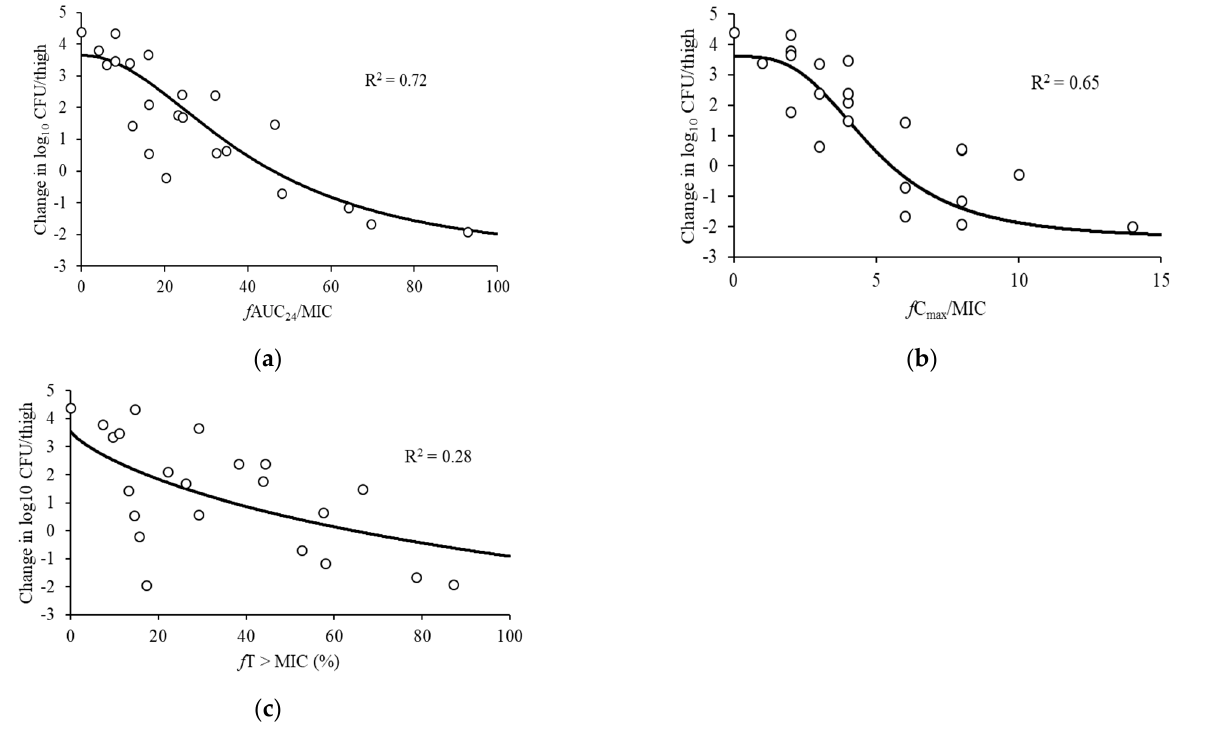
Figure 2. Relationships between the change in log 10 CFU/thigh at 24 h and PK/PD indices. ( a ) f AUC 24 /MIC, ( b ) f C max /MIC, and ( c ) f T > MIC for P . aeruginosa ATCC 27853. The horizontal dashed lines: organism burden at the start of therapy. Plot: mean for one thigh per mouse. R 2 : coefficient of determination. Table 2. Pharmacokinetic/pharmacodynamic (PK/PD) model parameter estimates predicting viable counts at 24 h for the f AUC 24 /MIC and f C max /MIC index of pazufloxacin against P . aeruginosa in the thigh infection